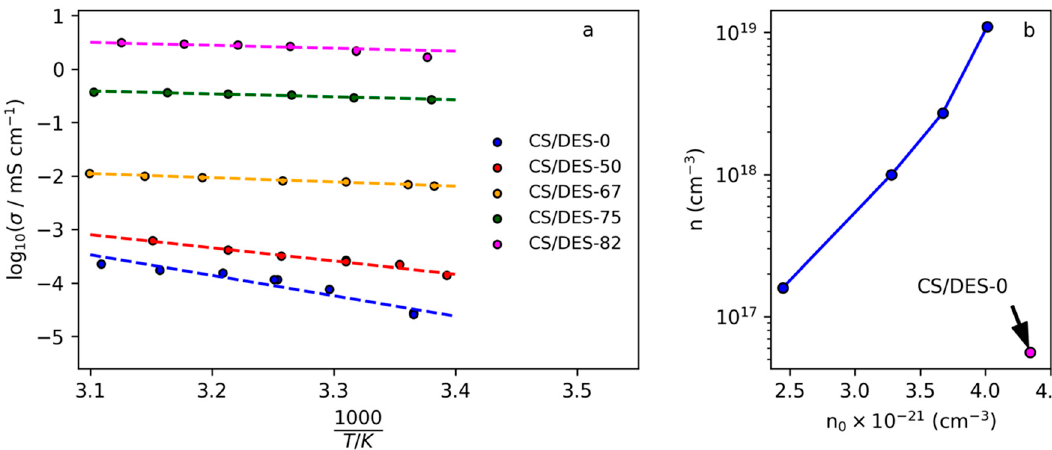
Figure 11. Dependences of logarithm of electrical conductivity on the reciprocal temperature for the film CS with LA and CS films prepared with di ff erent NADES content ( a ) and ( b ) dependence of the number density of charge carriers ( n ) on the number density of -COOH groups ( n 0 ) in the films.